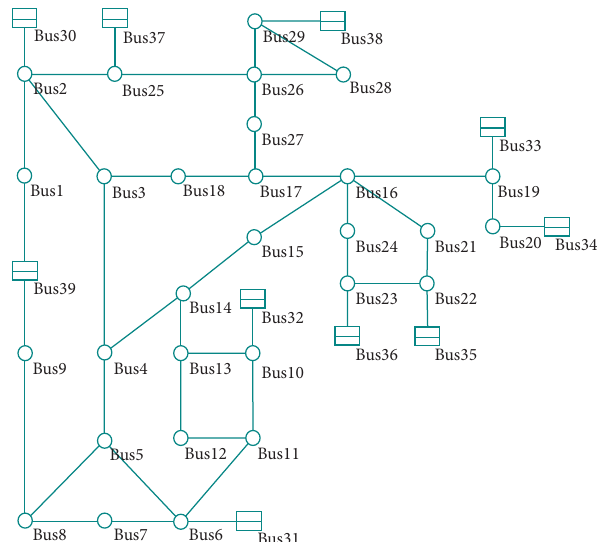
Figure 3: IEEE 39-node standard example geographic wiring diagram.